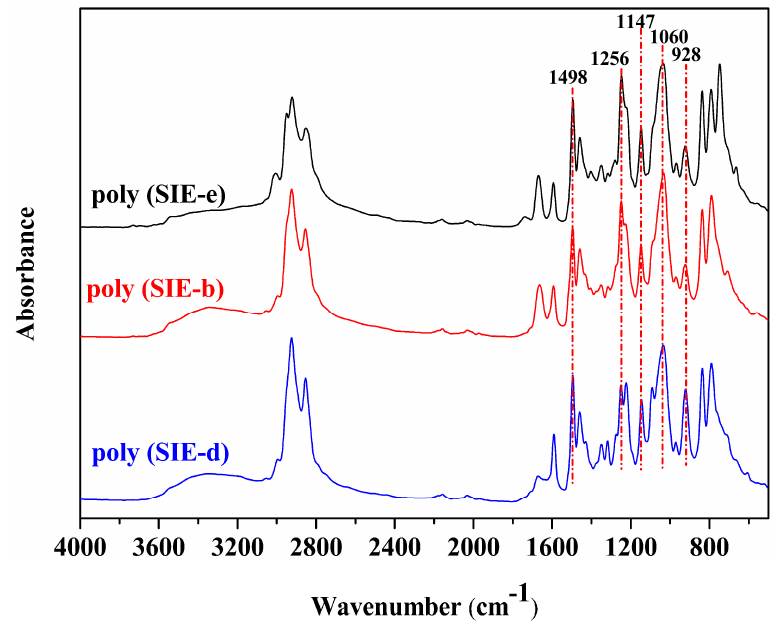
Figure 3. FT-IR spectra of different benzoxazine oligomers.